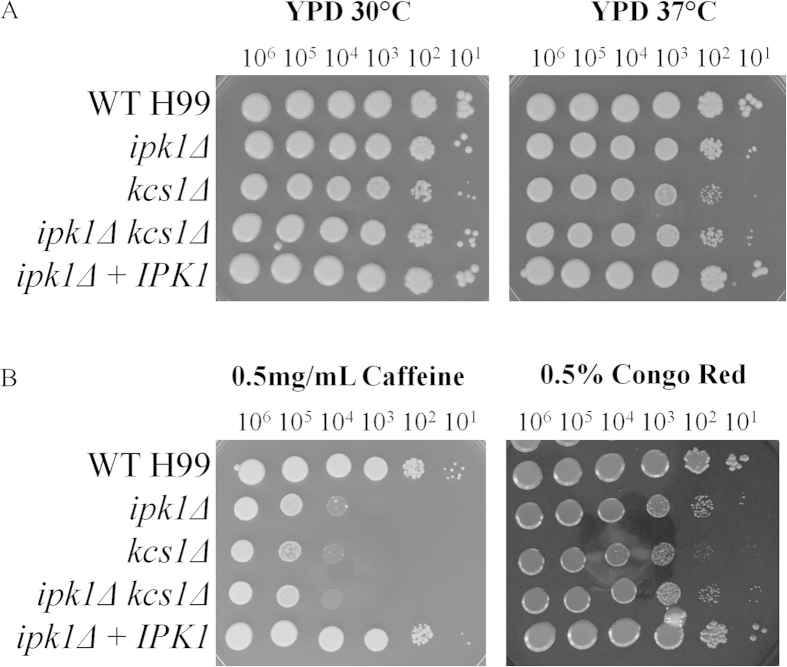
Effect of temperature (A) and cell wall perturbing agents (B) on growth of ipk1Δ, kcs1Δ and ipk1Δ kcs1Δ.All strains were serially diluted 10-fold, from 106 cells to 101 cells per 3μL (left to right) and dropped onto media containing the reagents indicated. All plates were incubated at 30 °C/37 °C for 72 hours. The YPD 30 °C plate was used as a control.